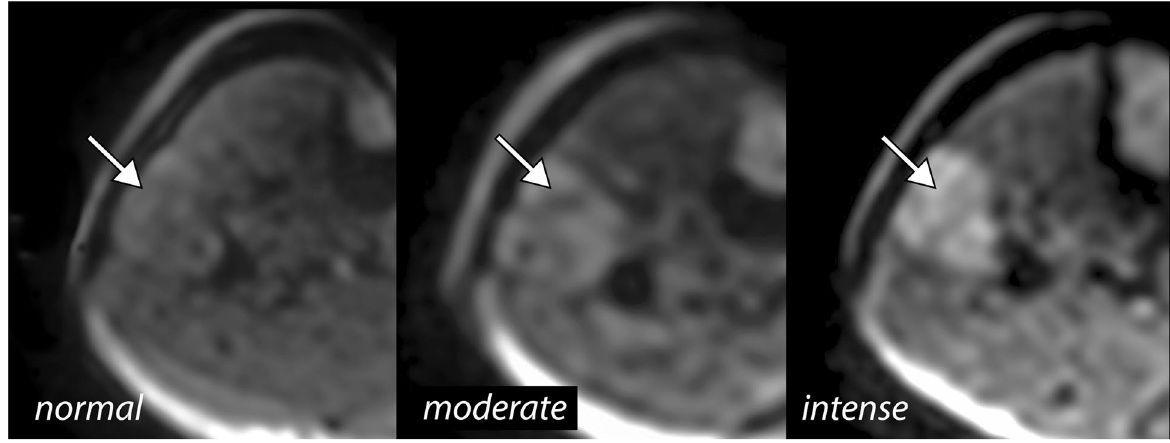
Fig. 1 Visual scale of signal change at the level of the lateral compartment